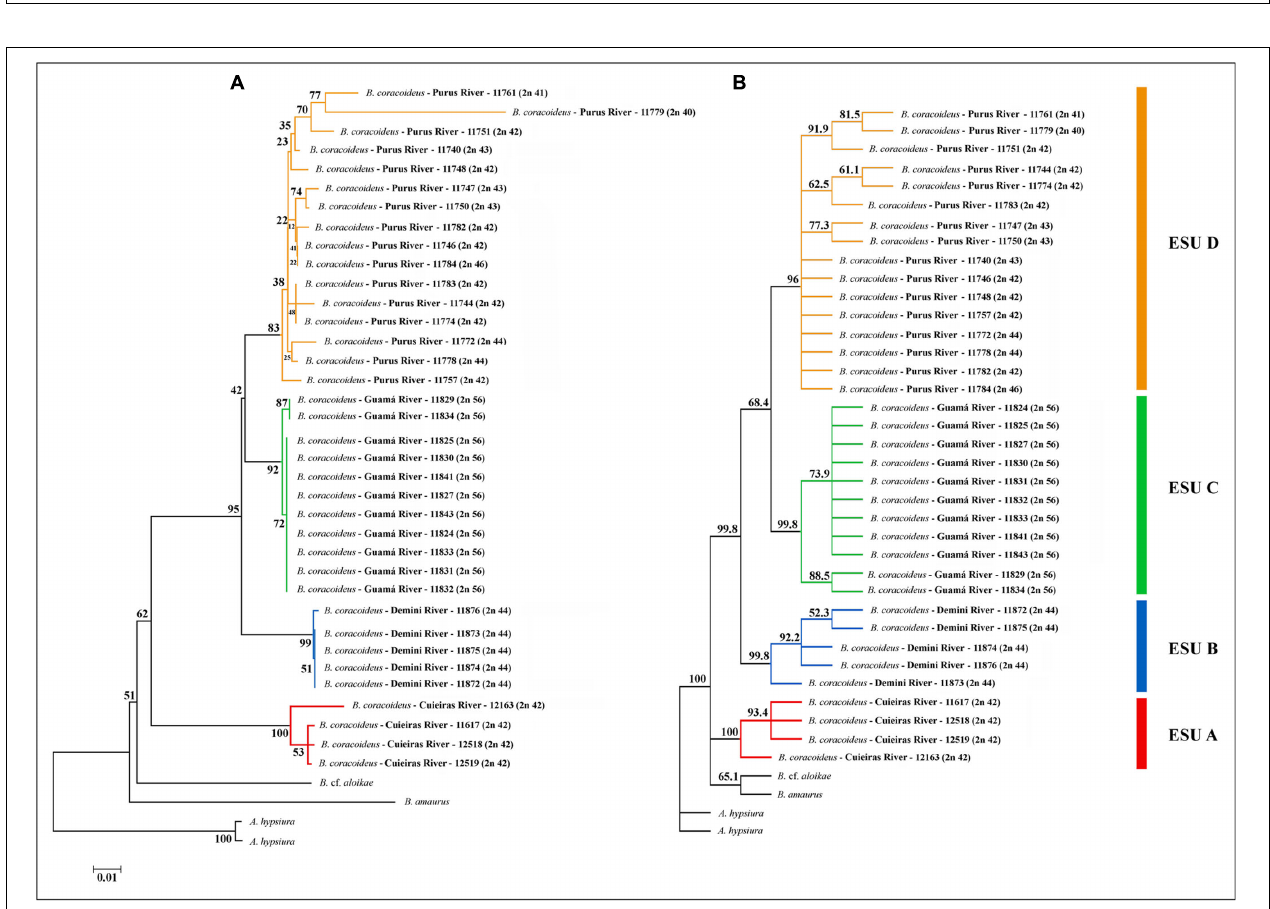
FIGURE 6 | Phylogeny of B. coracoideus inferred by the analysis of (A) Maximum Likelihood (ML) and (B) Neighbor-Joining (NJ) using the mitochondrial gene COI. The bootstrap values for 1000 replications are evidenced above the branches.